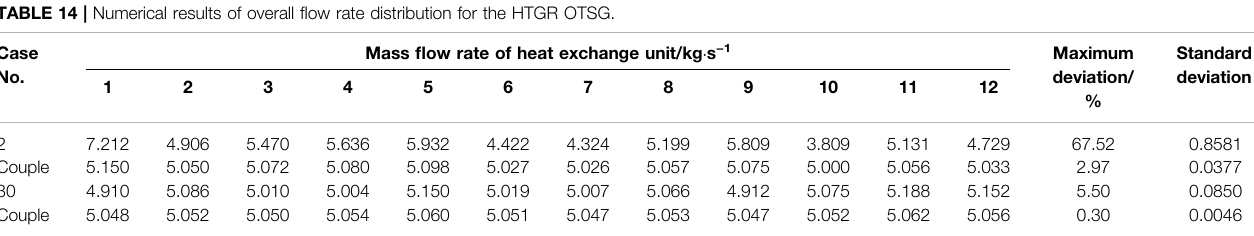
TABLE 14 | Numerical results of overall fl ow rate distribution for the HTGR OTSG. Case